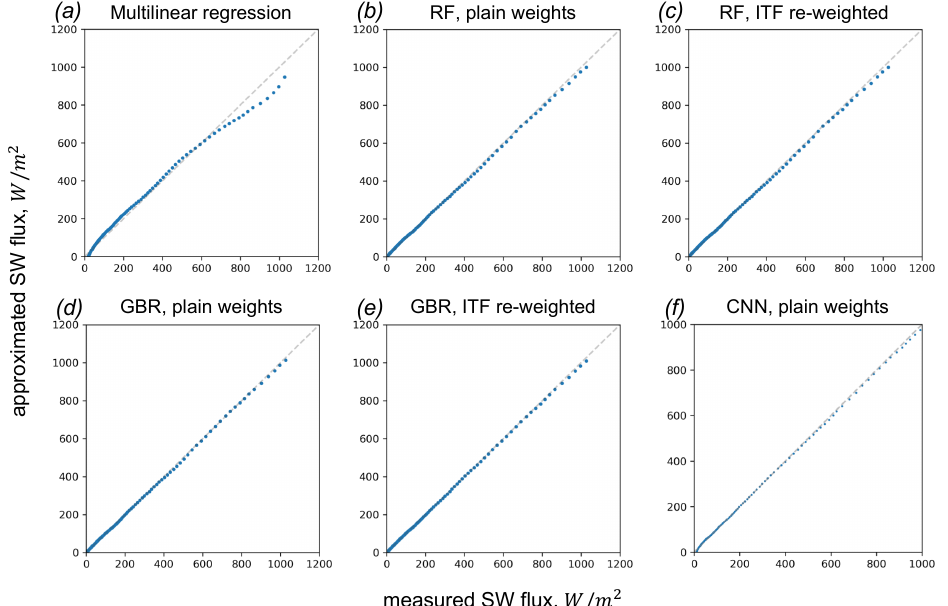
Figure 8. quantile–quantile plots for: ( a ) Multilinear Regression as a baseline; ( b ) Random Forests without ITF re-weighting; ( c ) Random Forests using ITF re-weighting of train subset; ( d ) Gradient Boosting for Regression without ITF re-weighting; ( e ) Gradient Boosting for Regression using ITF re-weighting of the train subset; ( f ) convolutional neural network (no re-weighting). Each diagram has been provided with a diagonal dashed line representing an ideal model mapping the distributions without any